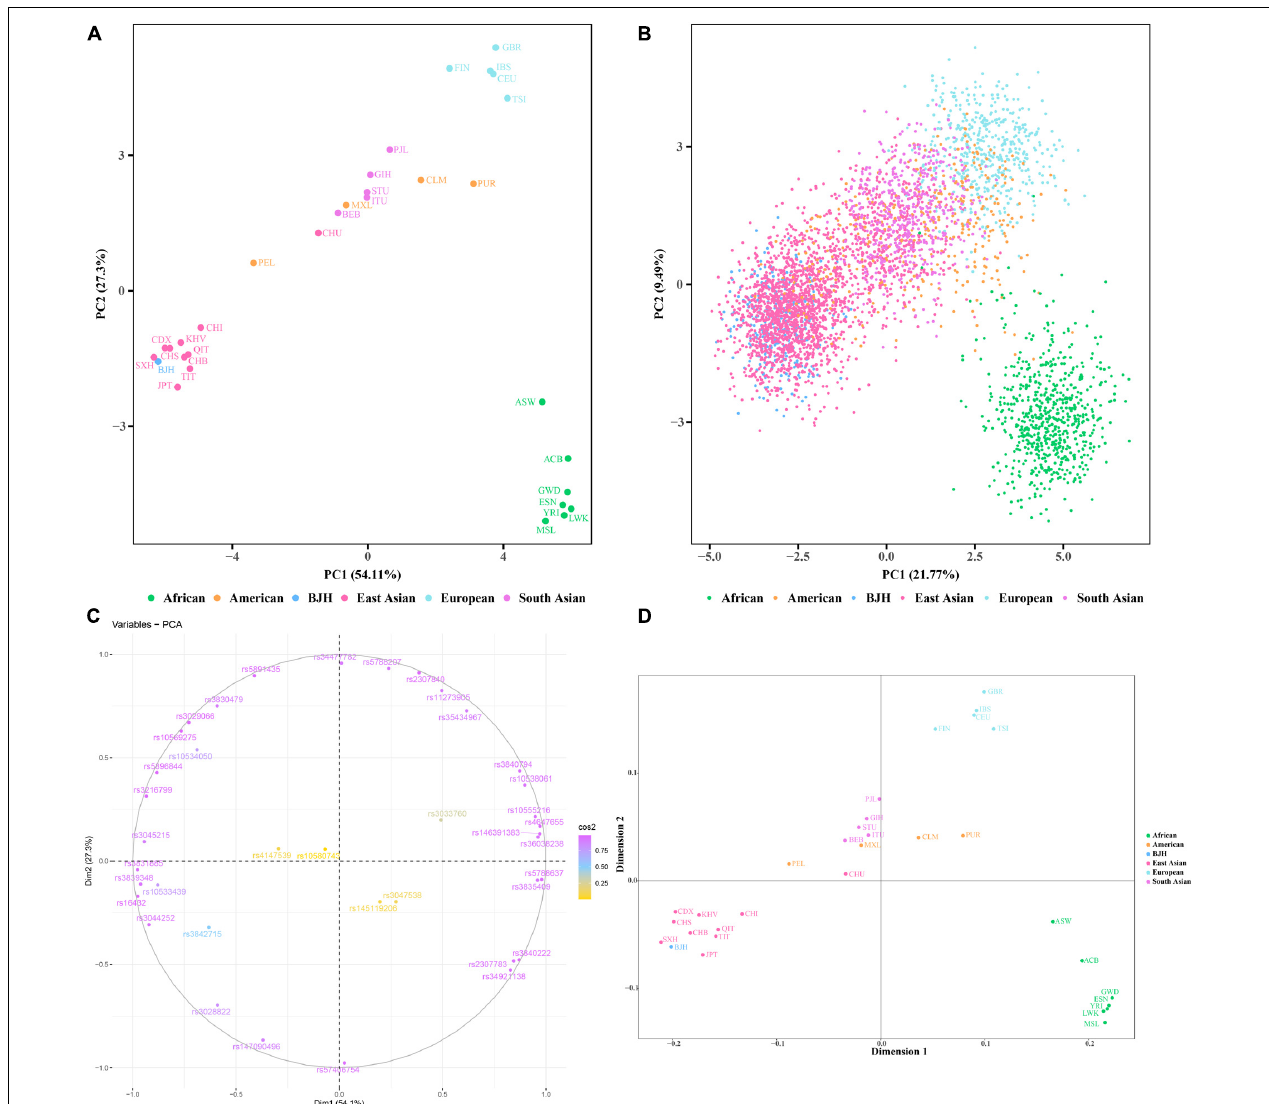
FIGURE 5 | The principal component analysis on the population level (A) and individual level (B) among the Beijing Han population and 31 reference populations; the cos2 values of 38 AIDIPs (C) ; the multidimensional scaling analysis based on the pairwise F ST values among the Beijing Han population and 31 reference populations